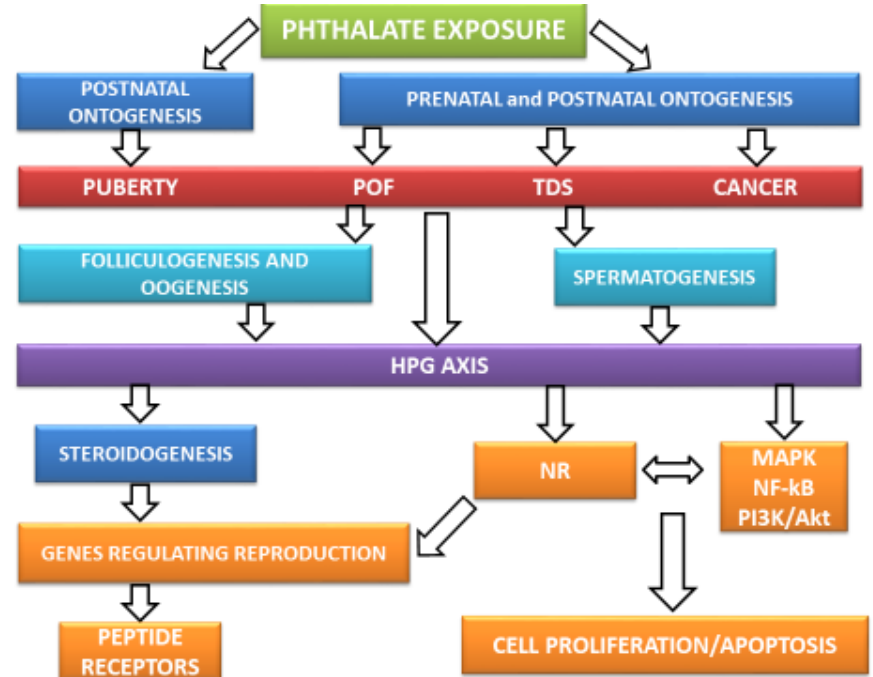
Figure 3. Side e ff ects of phthalate action on reproductive health: prenatal and postnatal exposure to phthalates induces a wide spectrum of reproductive disorders. Phthalates can induce the puberty onset alternation and cancer occurrence in both females and males. In males, phthalates can induce testicular dysgenesis syndrome (TDS), which is connected with impaired spermatogenesis. In females, the exposure to phthalates can induce premature ovarian failure (POF), which is linked with impaired oogenesis and folliculogenesis. These reproductive disorders are mainly associated with a disrupted HPG axis that a ff ects the process of steroidogenesis in both males as well as females. The activity of genes regulating reproduction can modulate steroidogenesis. These genes can be modulated by the activity of peptide and nuclear receptors (NR). Phthalates impair the peptide receptors and NR. Phthalates alter cell proliferation and apoptosis via crosstalk between MAPK, NF-kB, PI3K / Akt, and NR. This can lead to impaired spermatogenesis and cancer